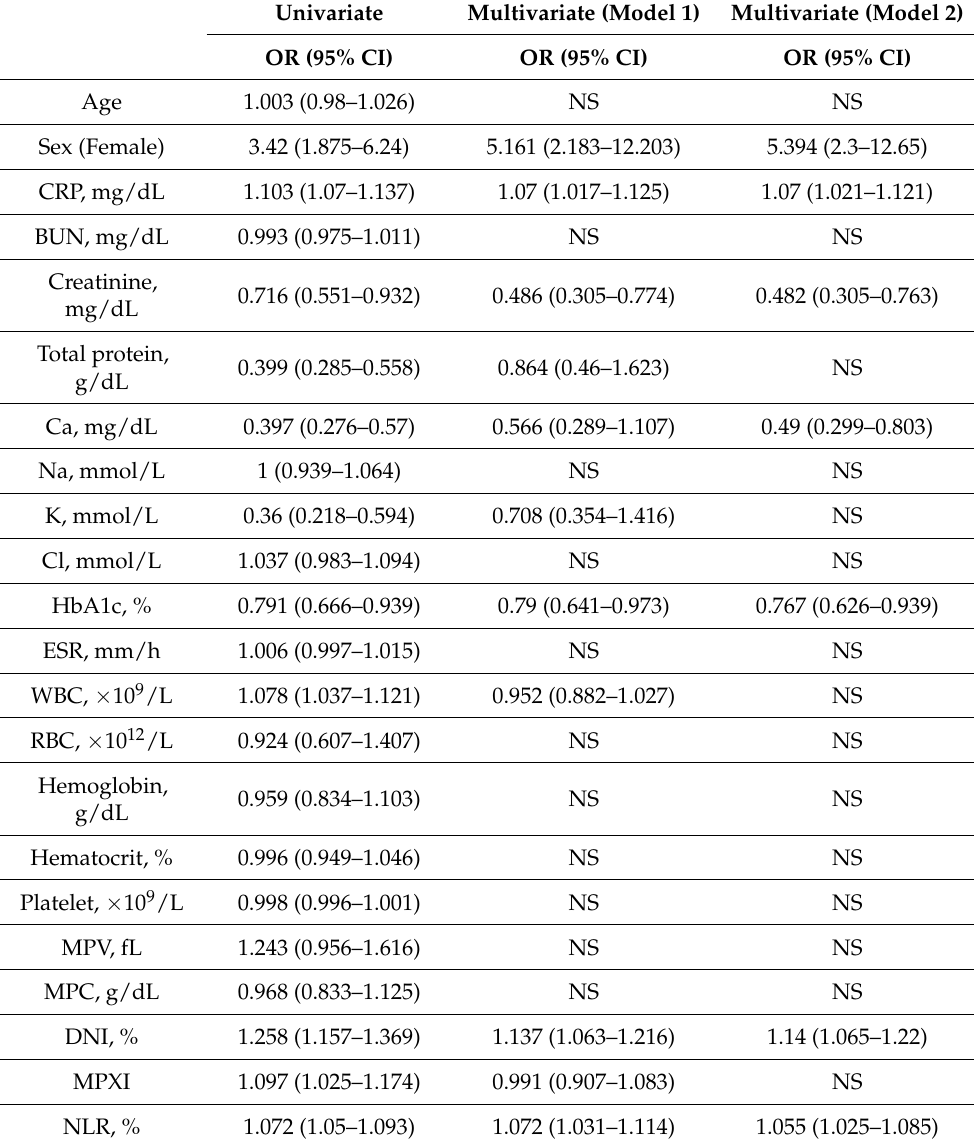
Table 2. Feature selection of prediction model for necrotizing fasciitis using backward stepwise logistic